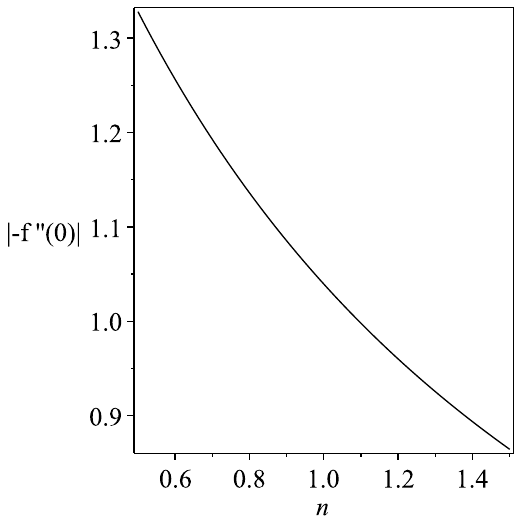
Fig. 11 Plot of |− (cid:98) f (cid:48)(cid:48) ( 0 ) | versus n , using Le = 3, Nb = 1, Pr = 5 and Nt = 0.